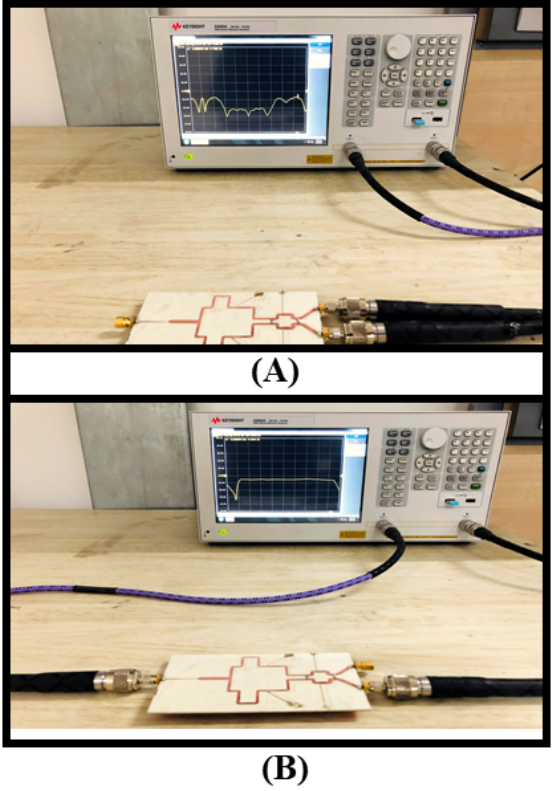
Figure 23. Measurement Setup for ( A ): S 23 ; ( B ): S 21 for θ c = 55 ◦